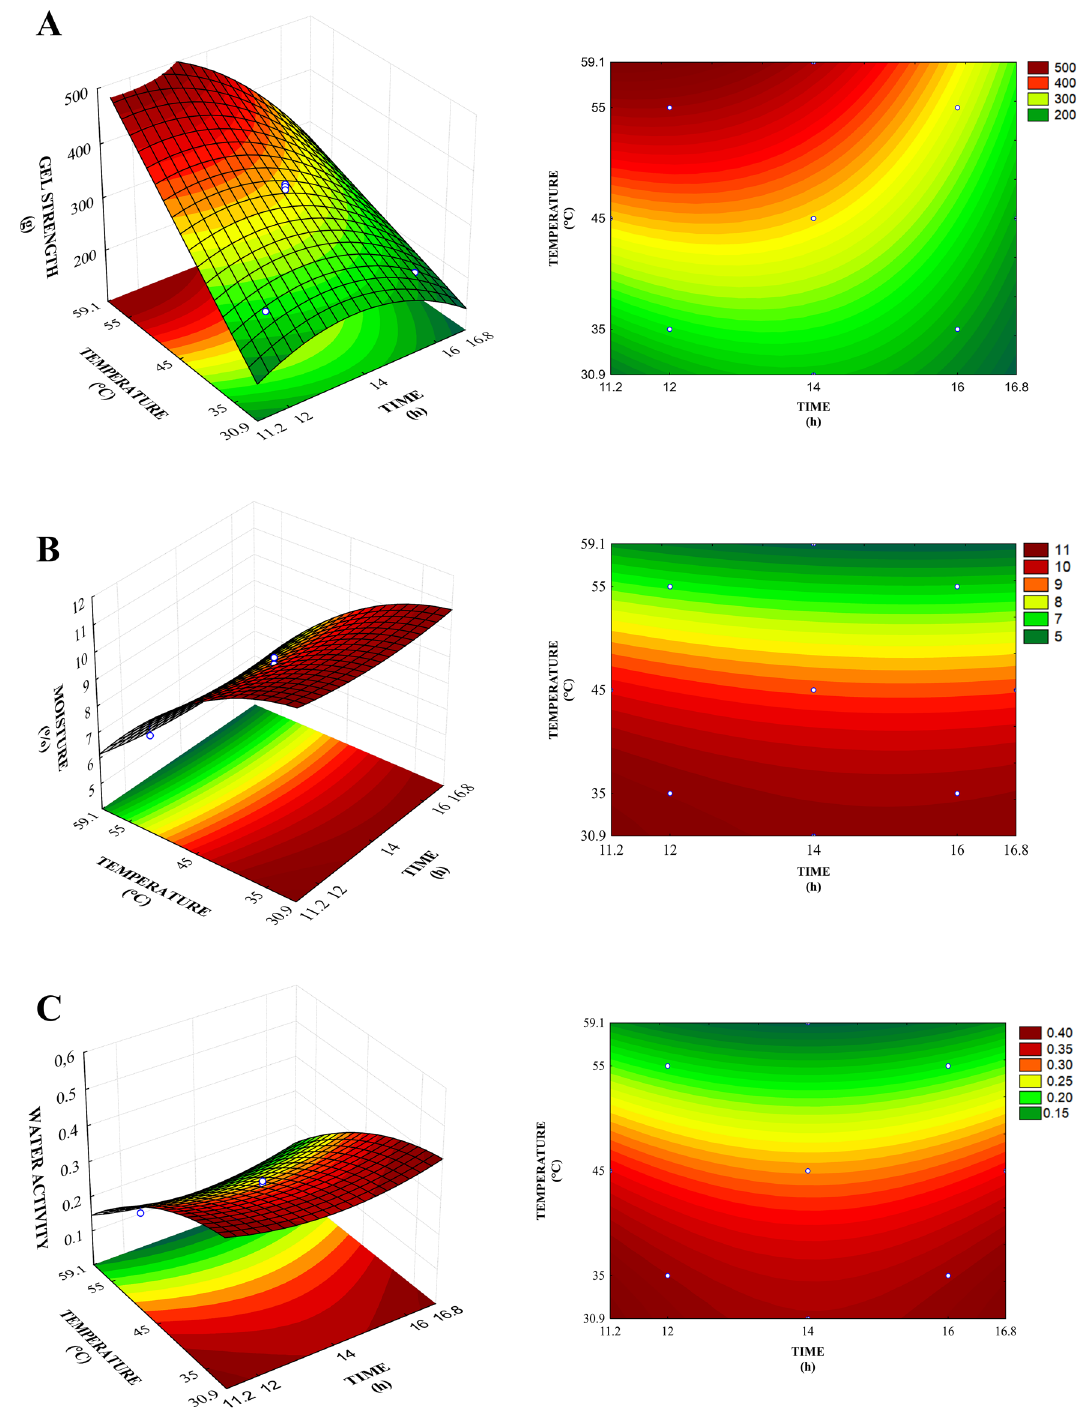
Figure 1. Response surface and level curve for gel strength ( A ), moisture ( B ), and water activity ( C ) relating time and temperature of convective drying of